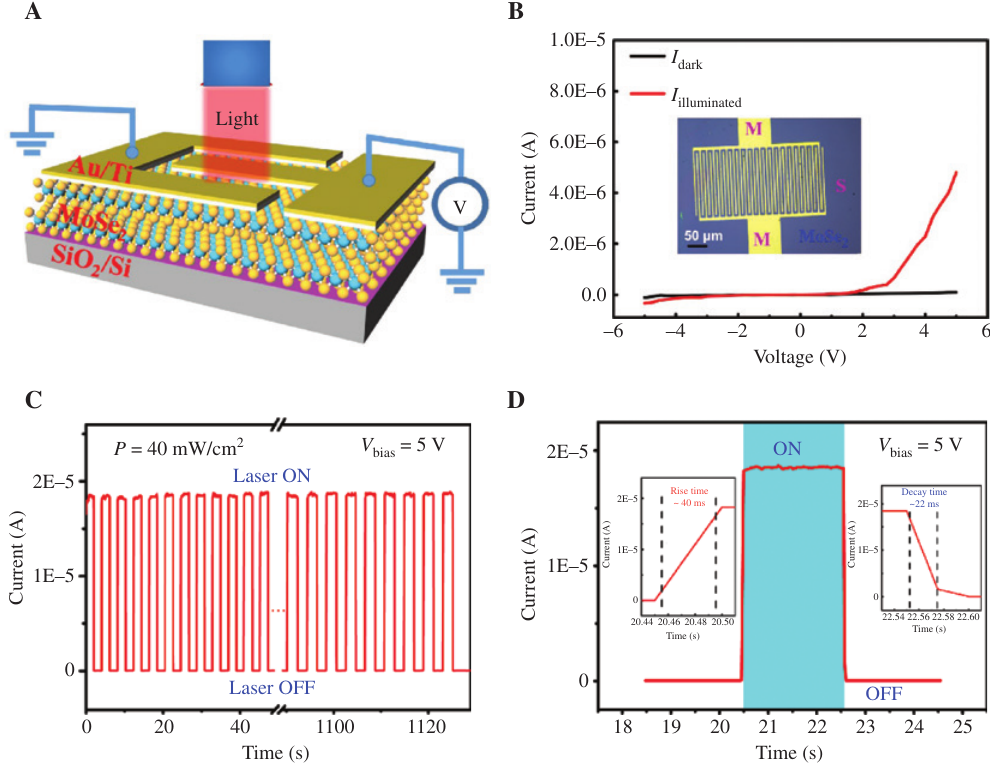
. Figure 5: Photoelectrical performance of a few-layer MoSe 2 (A) Schematic representation of MoSe MSM PD and a 638 nm laser beam was used for illumination. (B) I-V characteristics in the dark and 2 under light illumination. Inset shows the optical top-view image of a typical device. (C) Stability test of photoswitching behavior of the = 5 V and P = 40 mW/cm 2 . (D) Dynamic response characteristics of the PD measured at V device at V bias decay process are indicated in the